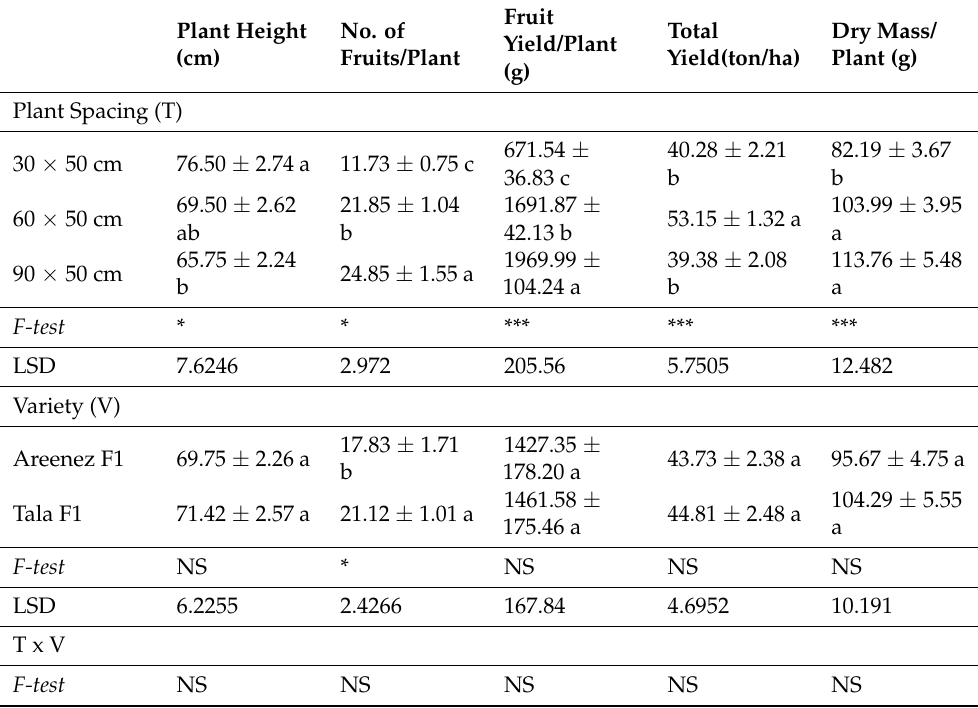
Table 3. Plant height (cm), number of fruits/plant, fruit yield/plant (g), total yield (ton/ha), and dry mass/plant (g) as affected by three plant spacings (30 × 50 cm, 60 × 50 cm, and 90 × 50 cm) in two tomato varieties during the winter season of 2020–2021. Fruit Total Dry Mass/ Plant Height No. of Yield/Plant Yield(ton/ha) Plant (cm) Fruits/Plant (g)